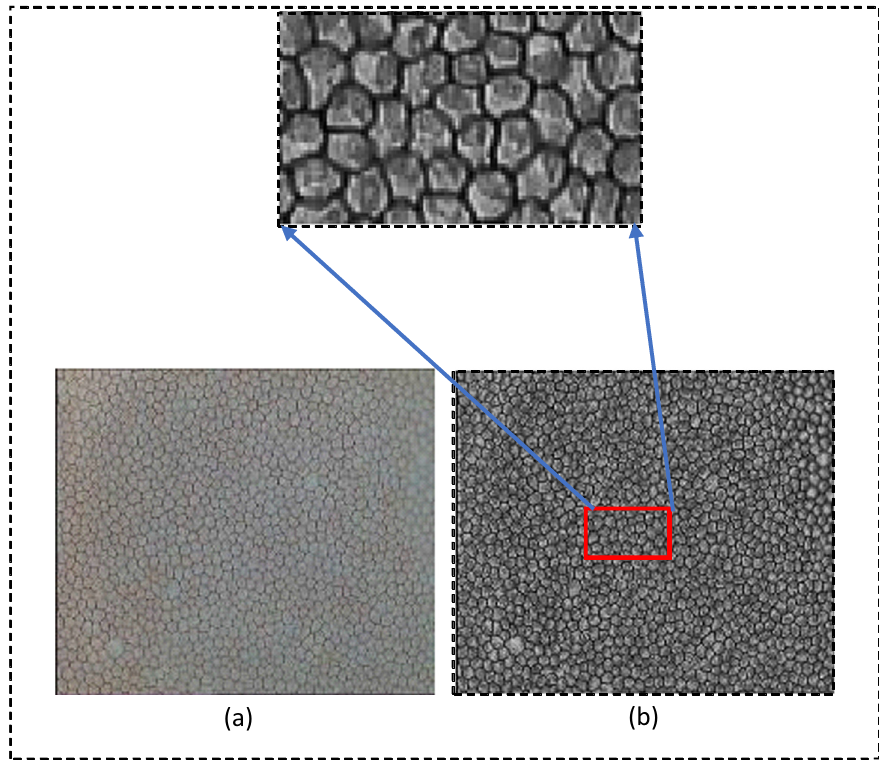
Figure 6: The e ff ect of CLAHE for sample 1: ( a ) the original image and ( b ) the fi ltered